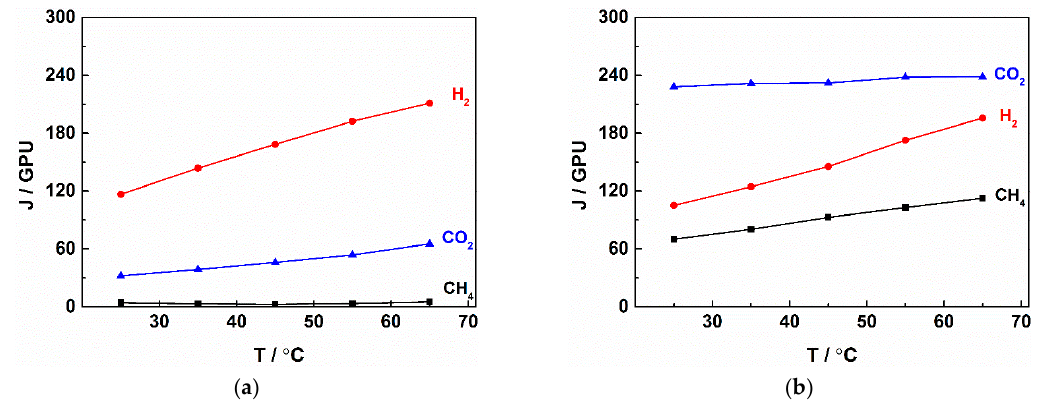
Figure 5. E ff ects of operating temperature on membrane performances. ( a ) PI membrane gas permeation Figure 5. Effects of operating temperature on membrane performances. ( a ) PI membrane gas rates; ( b ) PDMS / PEI membrane gas permeation rates. permeation rates; ( b ) PDMS/PEI membrane gas permeation rates.